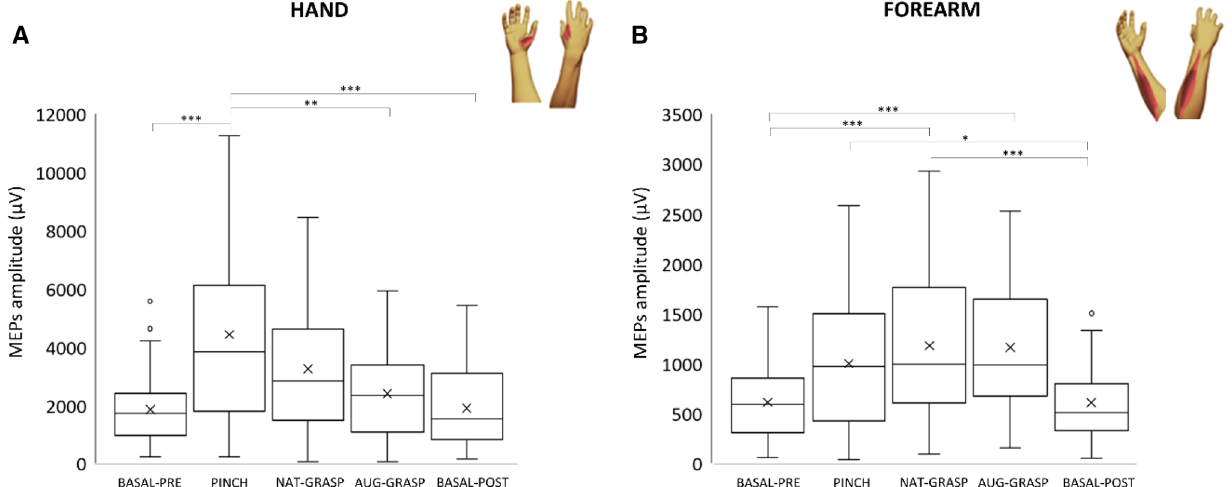
Figure 4. Intrinsic (“Hand”) versus extrinsic (“Forearm”) muscles effects. MEPs amplitude modulation versus Basal-Pre condition of distal HAND (FDI + APB) versus proximal FOREARM (EDC + FDS) muscles. Same organization as the previous figure.